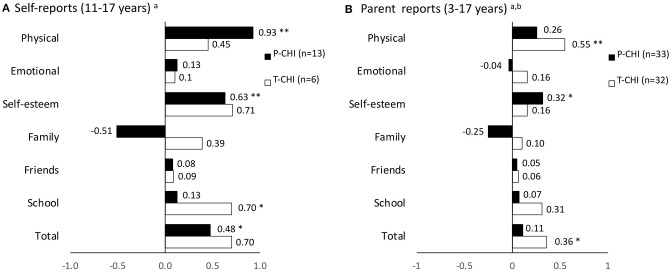
KINDL-R subscale and total mean z-scores according to age- and gender-specific reference values in the self-report groups (A) and parent report groups (B). P-CHI, persistent CHI; T-CHI, transient CHI; *P < 0.05; **P < 0.001; areference values of BELLA study of the KiGGS (9); breference values of KiGGS study (8).